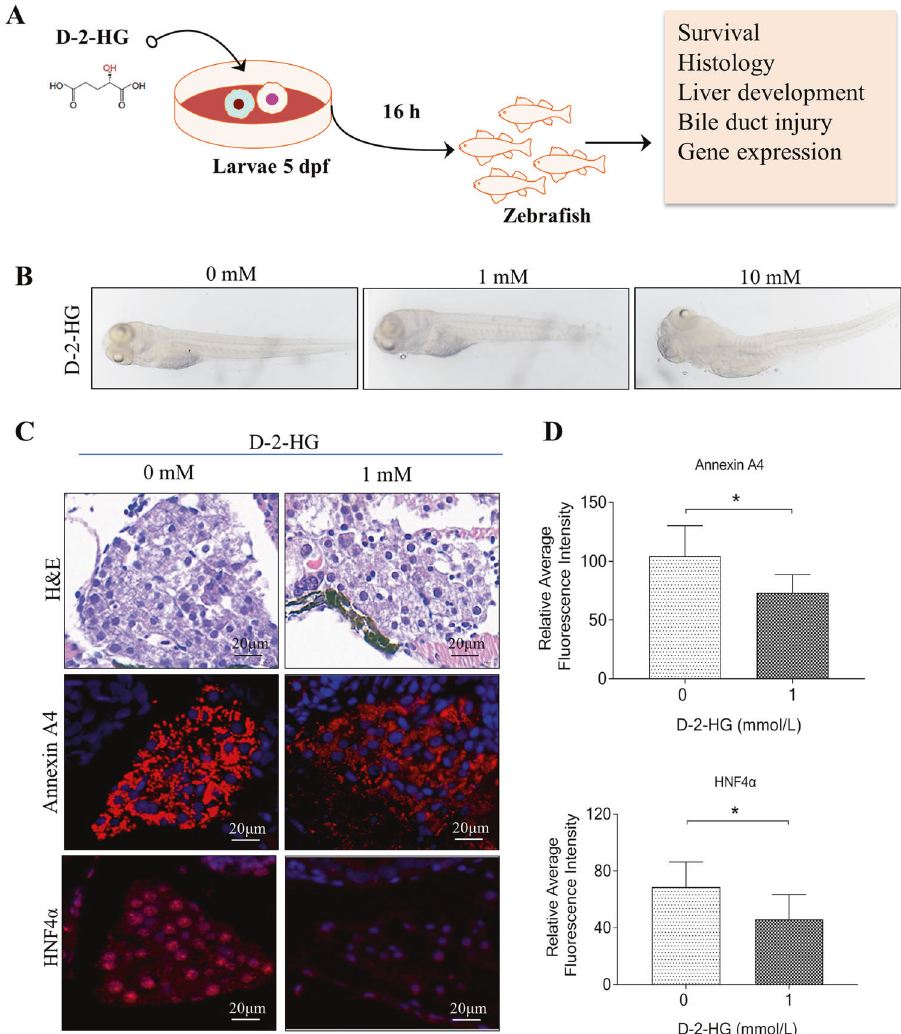
Fig. 7 D-2-HG exposure caused liver degeneration in zebra fi sh. A Experimental scheme depicting the treatment of 5 dpf larvae with different concentrations of D-2-HG (0, 0.5, 1, 5, 10, and 20 mM) for 16 h before analysis. B The whole morphology of larvae. C Livers of 5-dpf larvae were performed with hematoxylin-eosin (H&E) staining and immunostained with anti-Annexin A4 and HNF-4 α fl uorescence intensity. D Quanti fi cation of Annexin A4 and HNF-4 α in the panel ( C ). * P < 0.05, ** P <